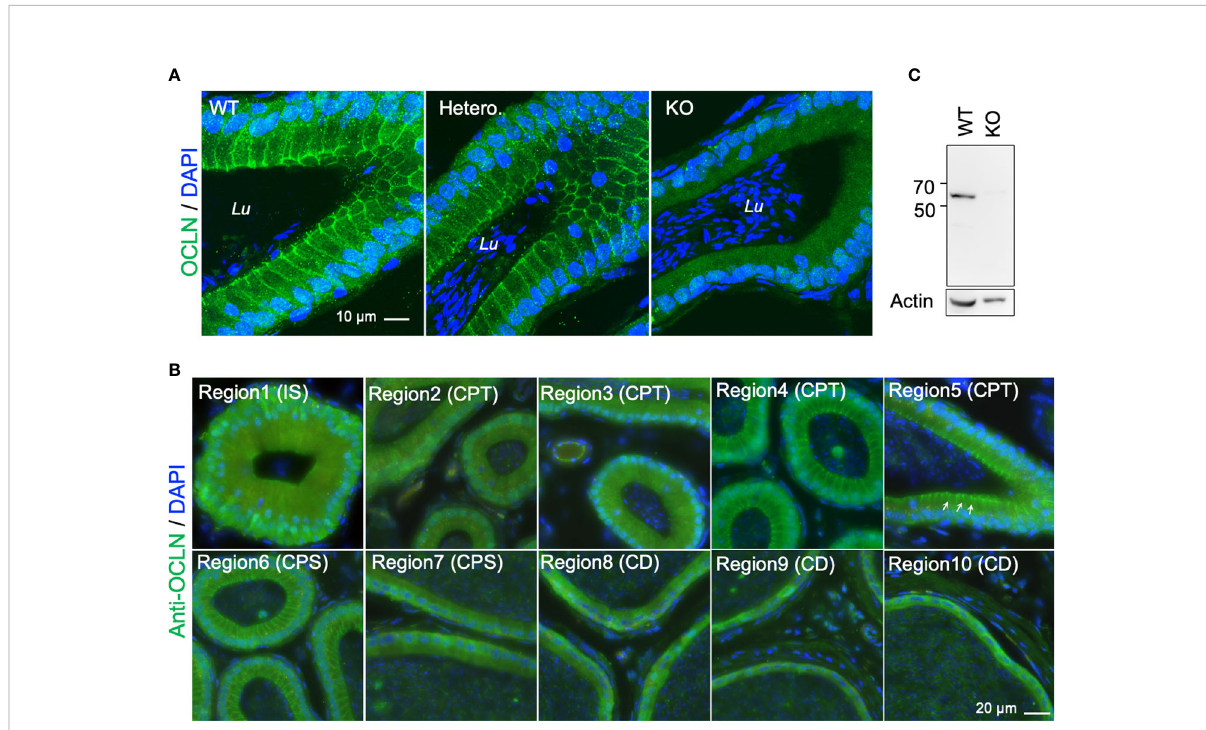
FIGURE 2 (A) Typical immuno fl uorescent-labelling of caput epididymal cryosection immunostaining for anti-OCLN antibody showing enriched OCLN protein in the apical junctional membranes of principal cells in epididymis from WT and heterozygous mice, but absent in Ocln -KO mice. (B) Immuno fl uorescent-labelling of epididymal cryosection immunostaining for anti-OCLN antibody showing enriched OCLN in region1-6 (IS, CPT and proximal CPS (pCPS) epididymidis). In IS, OCLN is only present in the TJs of principal cells. In the CPT and pCPS principal cells, OCLN also presents in the apical paracellular membranes (arrows). (C) WB-analysis of the same anti-OCLN antibody with KO and WT DC2 cell lysates. Lu, lumen; IS, initial segment; pCPT and dCPT, proximal and distal caput; CPS, corpus; CD, cauda epididymidis; Blue, DNA stained with